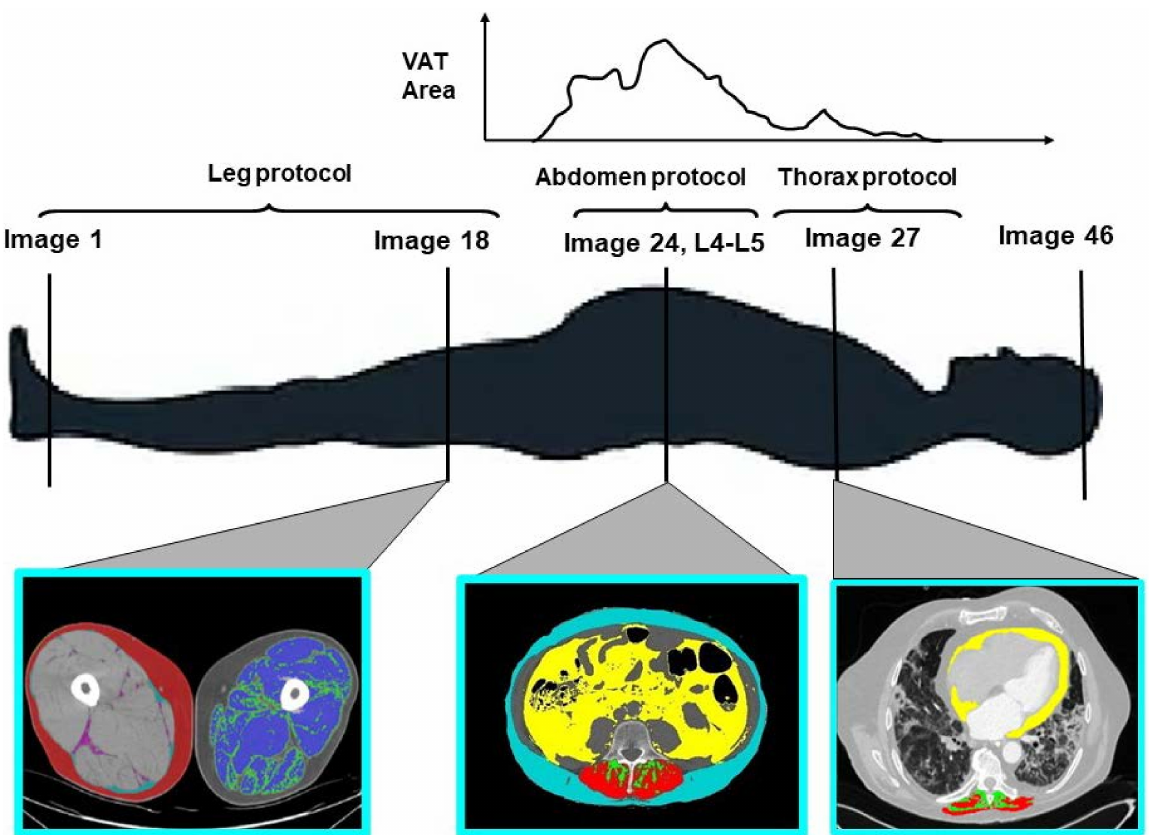
Figure 1. Computer tomography imaging protocol for both whole-body and regional (i.e., left to right, leg, abdomen, thorax, etc.) measures of adipose tissue and lean